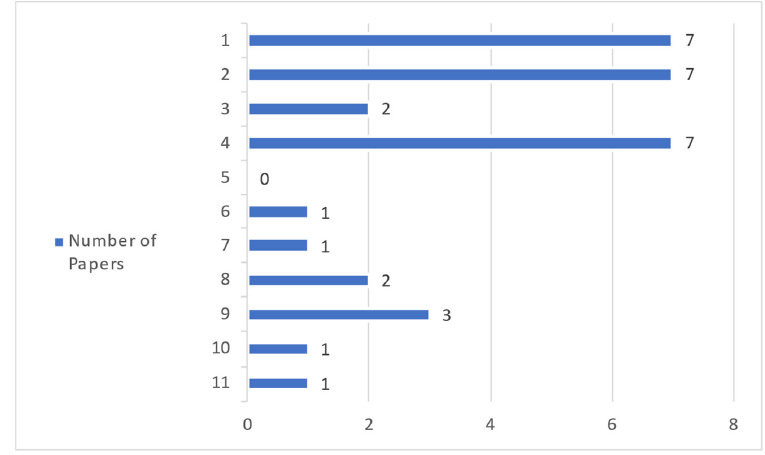
Figure 10. Number of scientific papers by number of authors.